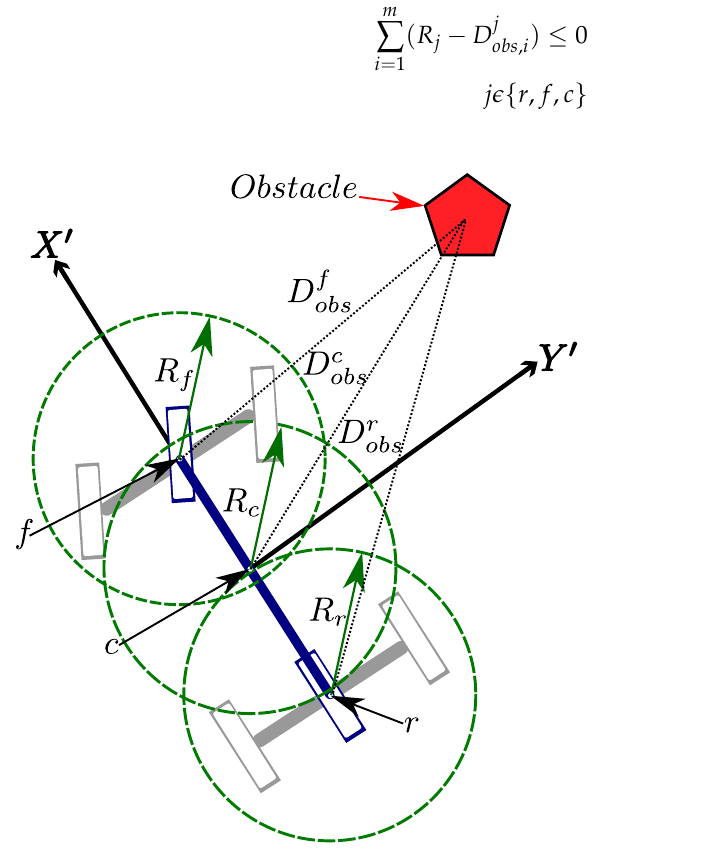
Figure 5. Set of secure radius collision-free checker. The center of circles are placed along the X